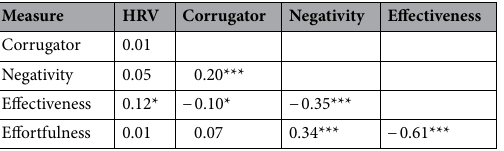
Table 2. Matrix of Pearson’s correlations between collected measures. ***, p < 0.001; **, p < 0.01; *, p < 0.05.